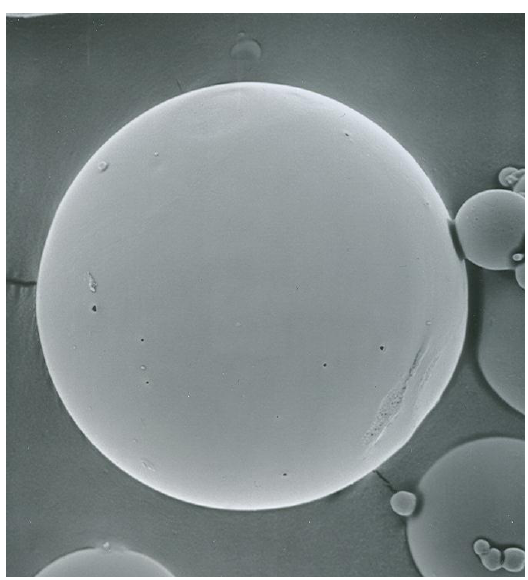
Figure 1: Scanning electron microscopy of KSL peptide loaded RG503 microspheres